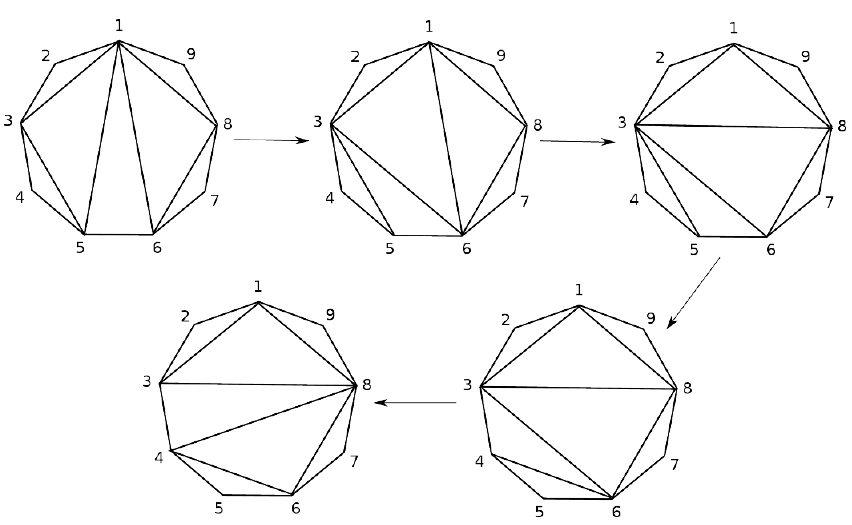
Figure 12. Monodromy action via a sequence of (cid:13)ips of triangulations of the